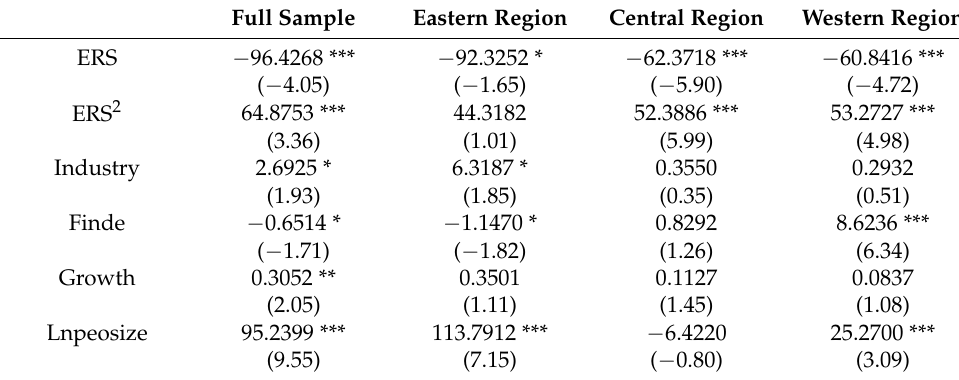
Table 15. Non-linear relationship between environmental regulation and the innovation capacity of